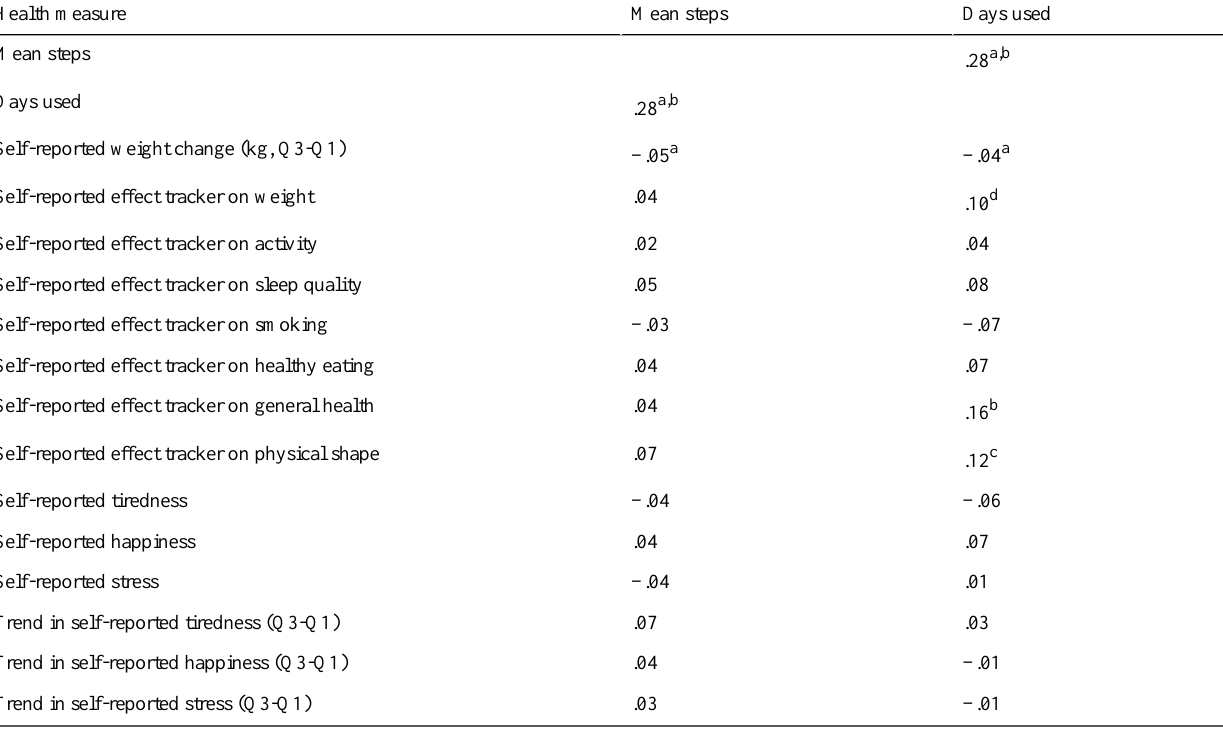
Table 1. Correlations (Spearman r, unless marked with b: Pearson r ) between steps taken, days worn, and health measures. All measures are from Q3 unless otherwise noted.